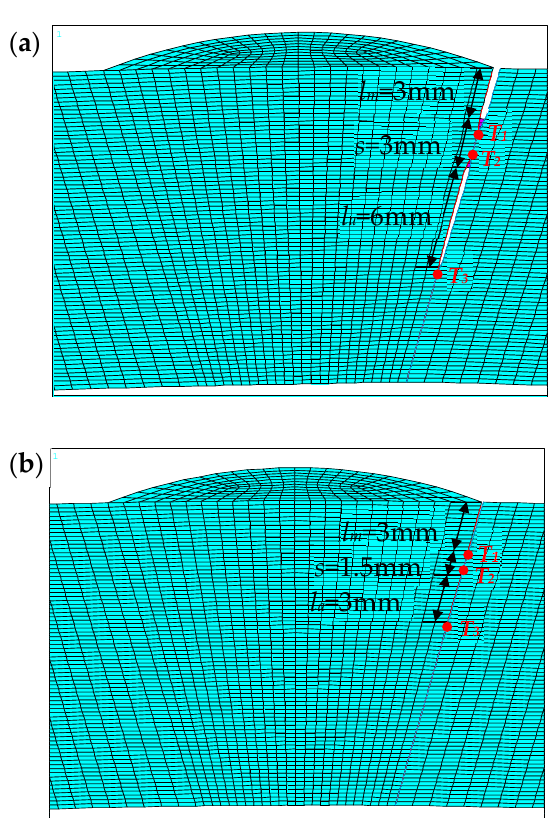
Figure 14. First set of simulation models: l m = 3 mm, X = 0, Y = 1. ( a ) 𝛾 (cid:3046) = 1 ， 𝛾 (cid:3039) =